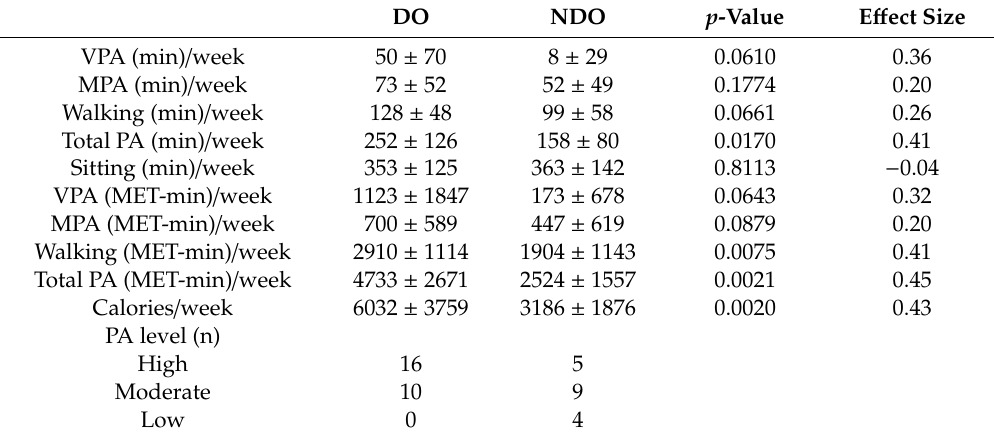
Table 3. Comparing the DO and the NDO using data from IPAQ (International Physical Activity Questionnaire), mean ± SD.